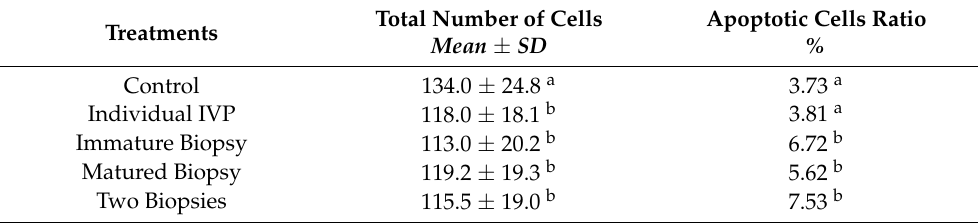
Table 3. Means and standard deviation (mean ± SD) of the number of total cells and the percent- age (%) of apoptotic cells of D7 expanded blastocyst (Bx). Embryos were originated from cumulus oocyte complexes (COCs) submitted to in vitro maturation, fertilization, and culture in groups (Con- trol), individually (Individual IVP) or individually and submitted to cumulus cells (CC) biopsy, before (Immature Biopsy), undergoing maturation (Matured Biopsy), and before and after in vitro maturation (Two Biopsies).